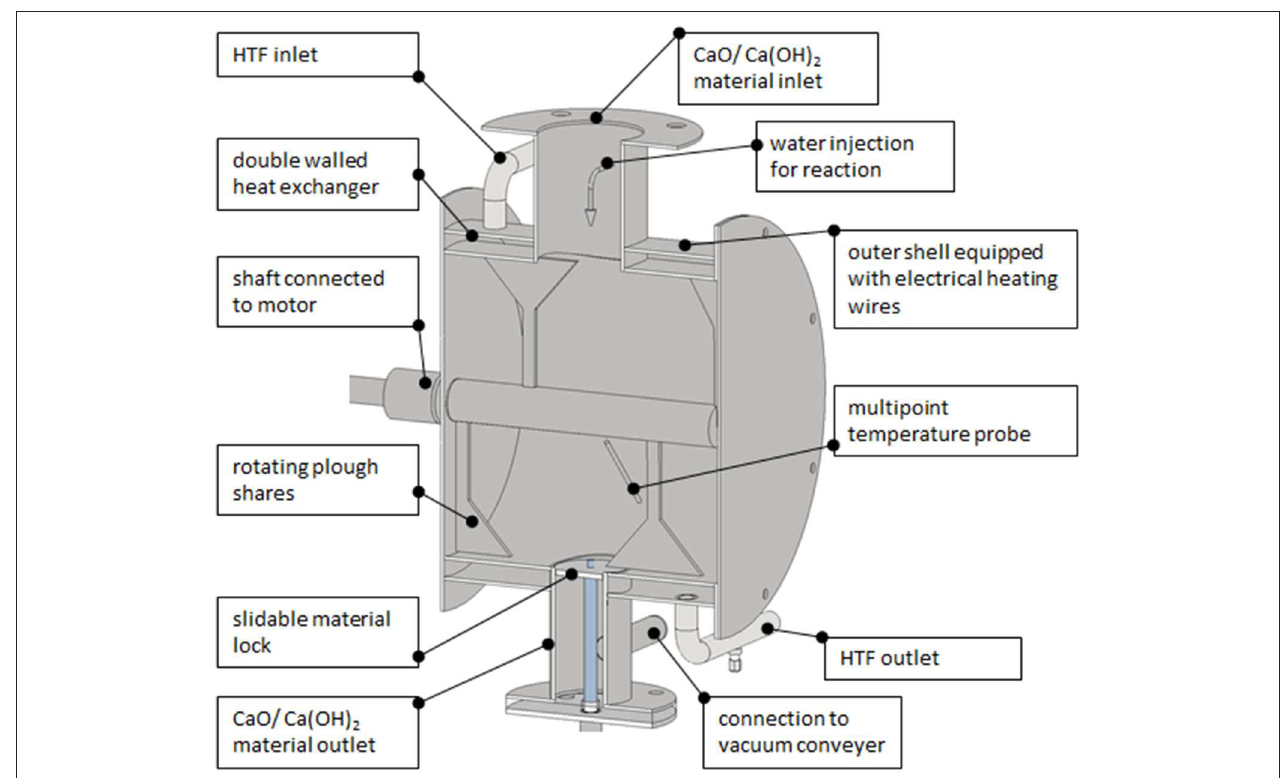
FIGURE 3 | Thermochemical storage reactor for electrical charging and thermal discharge with liquid water.